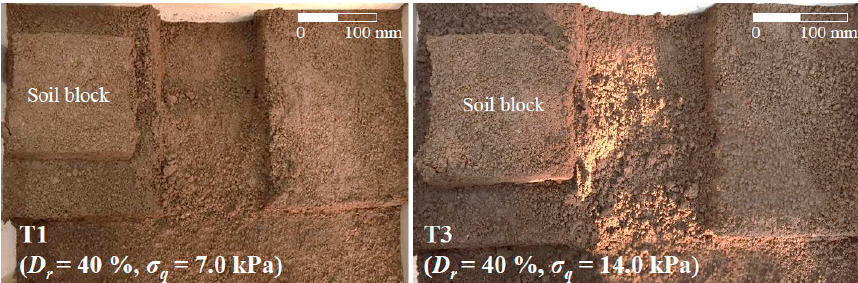
Figure 8. Shape of the failure surface after removing the soil block (top-view).